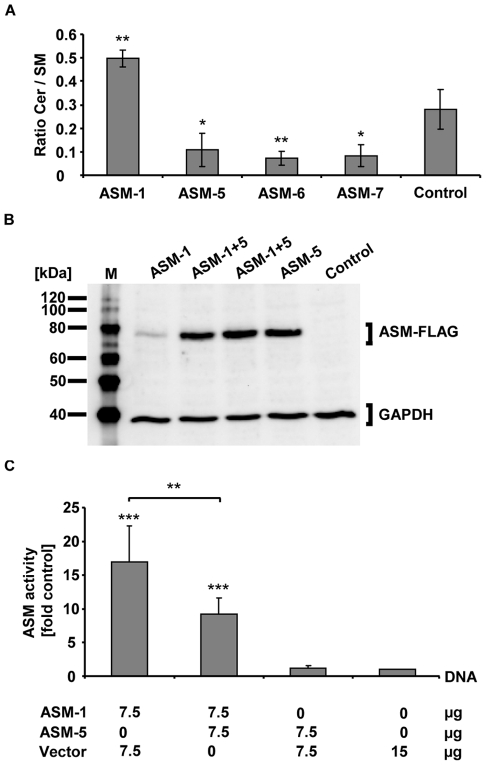
New ASM splice variants act in a dominant-negative manner. A. Modulation of ceramide:sphingomyelin ratios.The ratio of ceramide levels to sphingomyelin levels significantly increased after ASM-1 overexpression (p<0.01). In contrast, the ratio significantly decreased upon overexpression of ASM-5, -6 and -7 (p<0.01 for ASM-6; p<0.05 for ASM-5 and -7). Lysates were subjected to MALDI-TOF MS for sphingolipid analysis 24 h after transfection of H4 cells. The data indicate mean values of n = 3 independent experiments; error bars indicate SD. Statistical significance was calculated with respect to the control using the t-test (*p<0.05, **p<0.01). B. Co-expression of ASM-FLAG constructs in HeLa cells. ASM-1 and ASM-5 produced proteins that corresponded to their predicted sizes independent of single- or co-transfection. For control reasons lysates derived from two independent co-transfections were used. Lysates were analysed by Western blotting 72 h after transfection. ASM-FLAG variants were detected using an anti-FLAG antibody. The cloning vector served as a negative control; GAPDH was used as a loading control. M indicates the size marker. C. ASM-5 exerts a dominant-negative effect on ASM-1. ASM-1 overexpression generated high ASM activity relative to a vector control (p<0.001). Co-expression of ASM-1 and ASM-5 at a ratio of 1:1 led to a significant reduction in ASM activity relative to conditions where ASM-1 was expressed alone (p<0.01). ASM activity levels of this co-expression were still above a vector control (p<0.001). HeLa cells were transfected with 15 µg of ASM-FLAG constructs and cultured for 48 h. After 24 h of serum-starvation lysates were subjected to an in vitro enzyme activity assay. The results are presented as the fold increase in ASM activity relative to a negative control. The displayed data represent mean values of n = 6 independent experiments; error bars denote SD. Statistical significance was calculated using one-way ANOVA including a Bonferroni post-hoc test (**p<0.01, ***p<0.001).